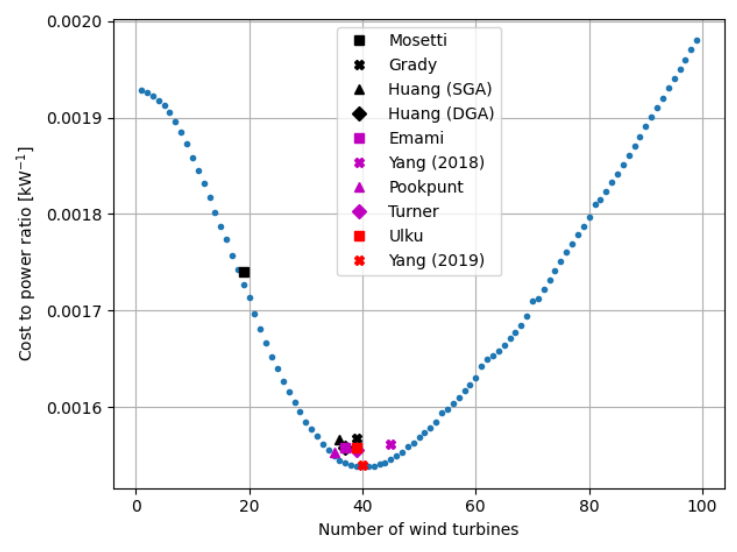
Figure 11. Fitness function values for case 2 for a given number of wind turbines.